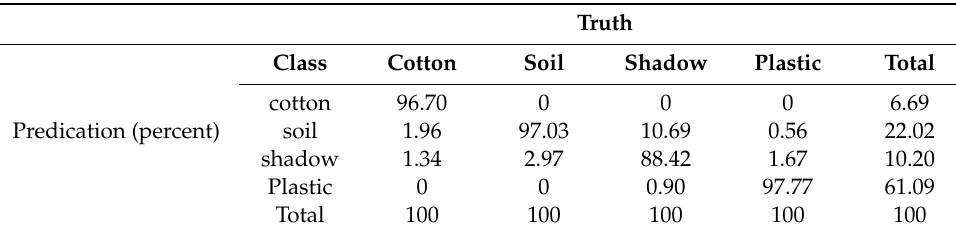
Table 2. Confusion Matrix of the classification (percent).